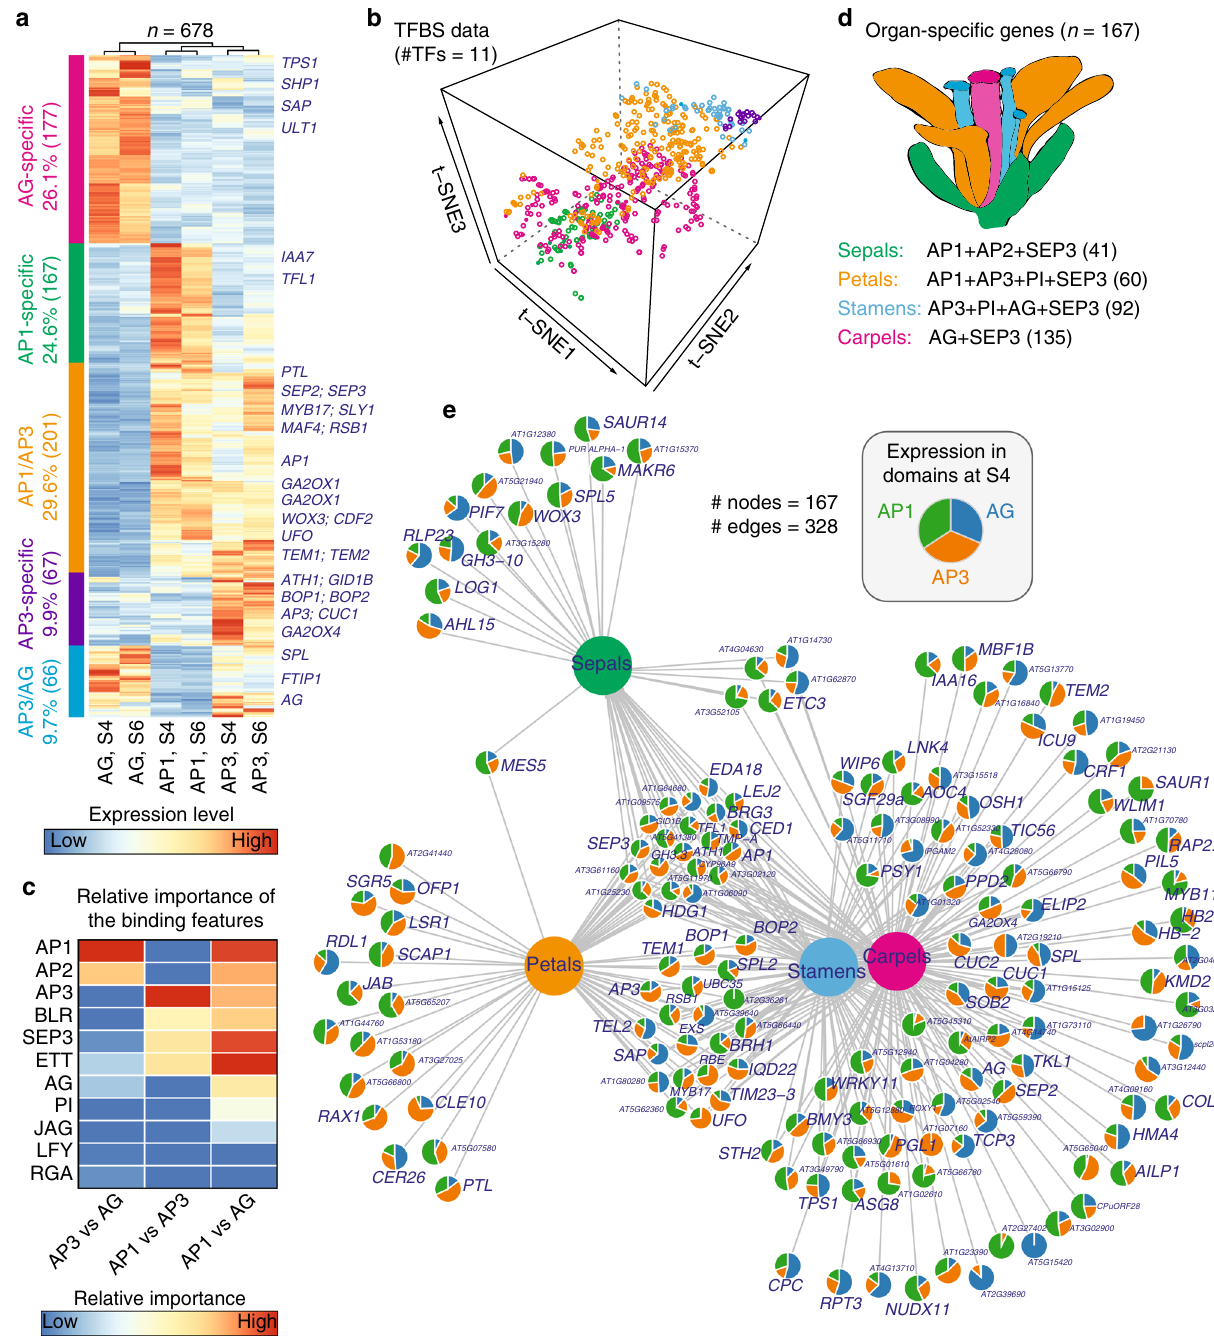
Fig. 5 Organ-speci fi c gene expression controlled by fl oral master regulators. a Clustering analysis of domain-speci fi c gene expression. Five major clusters correspond to fi ve distinct spatiotemporal domains (colored in left bars): AP1-, AP3-, AG-speci fi c, “ AP1/AP3 ” (AP1 and AP3-common domains), and “ AP3/ AG ” domains. Dendrograms above the heatmap illustrate the overall similarity of gene expression patterns. Example genes are indicated in the right. Domain expression data at stages 4 (S4) and 6 (S6) were obtained from ref. 62 . b 3D t-SNE (t-distributed stochastic neighbor embedding) plot showing the overall similarity of transcription factor (TF)-binding pro fi les of organ-speci fi c genes. Normalized ChIP-seq intensity for the 11 selected TFs were used in the analysis. c Predicting the contributions of promoter binding by multiple TFs to gene expression difference between two different domains by a